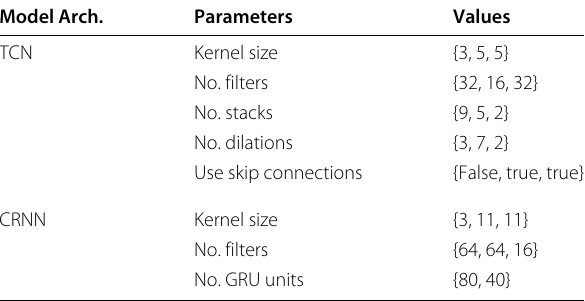
Table 2 Parameters for TCN and CRNN model architecture Model